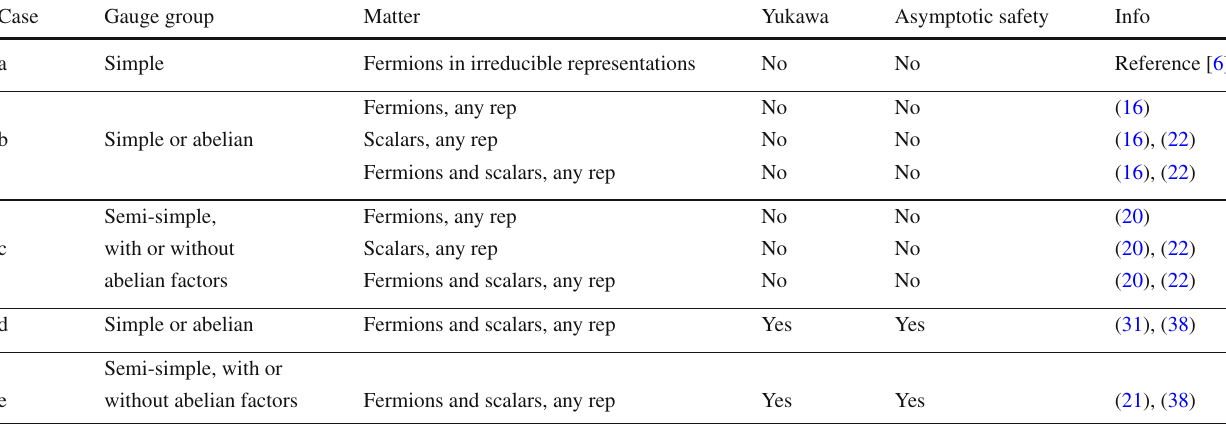
Table 2 Asymptotic safety in gauge theories coupled to matter with a–c stating strict no go theorems and d–e necessary and sufficient